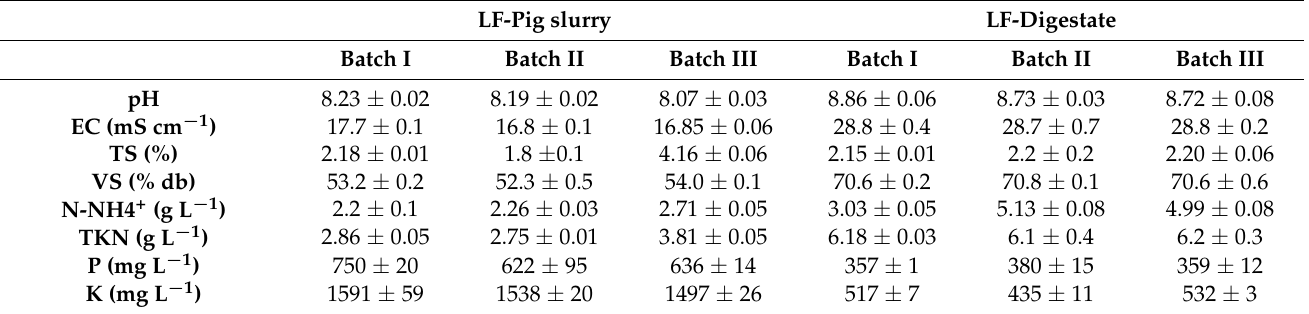
Table 2. Physicochemical characterization of the feedstocks (liquid fractions from pig slurry and